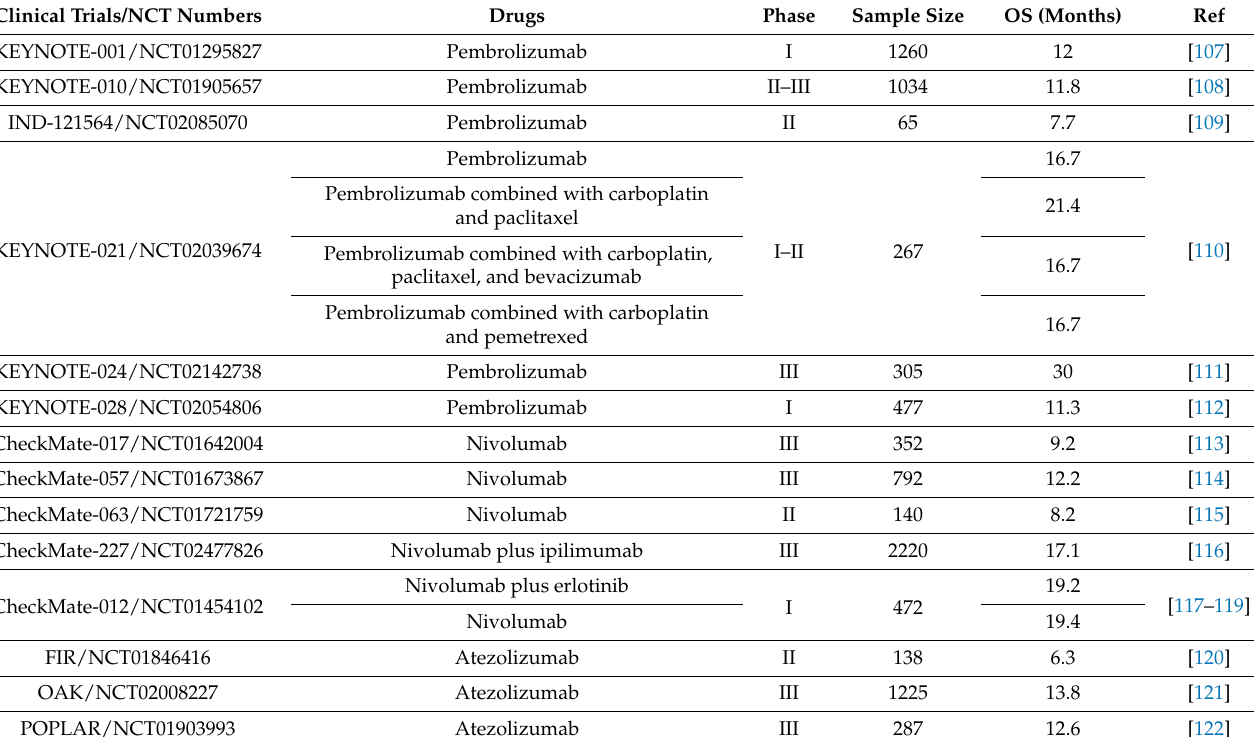
Table 1. Clinical trials evaluating the use of ICIs in